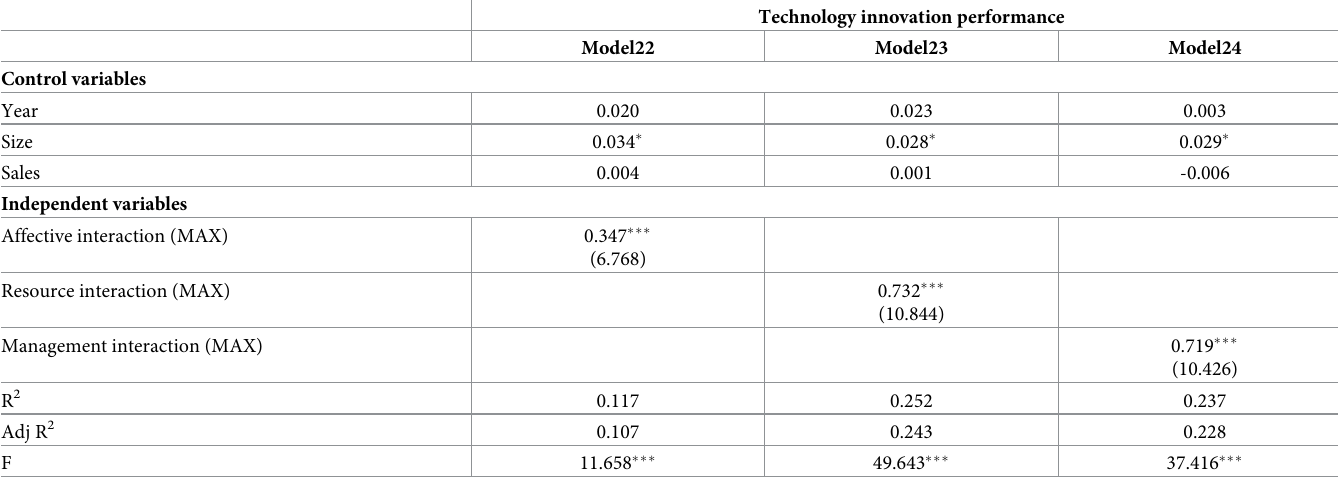
Table 7. The results of robust